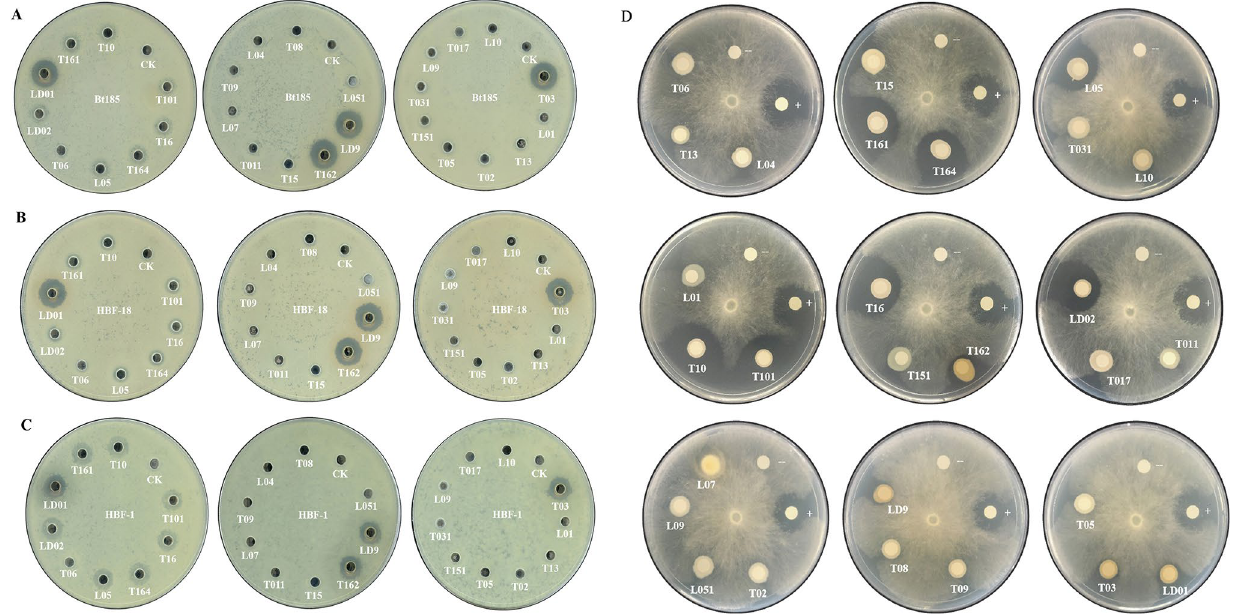
Figure 5. Effect of 28 cultivable isolates against the scarab-specific Bt strain Bt185 ( A ), HBF-18 ( B ), HBF-1 ( C ), and Bb strain ( D ). CK in ( A ), ( B ), and ( C ) and symbol “−” in ( D ) signifies negative control. The symbol “+” in ( D ) signifies positive control. Strain ID prefixed with “LD” indicates egg surface isolates, strain ID prefixed with “L” indicates SEC isolates, and strain ID prefixed with “T” indicates bulk soil isolates.